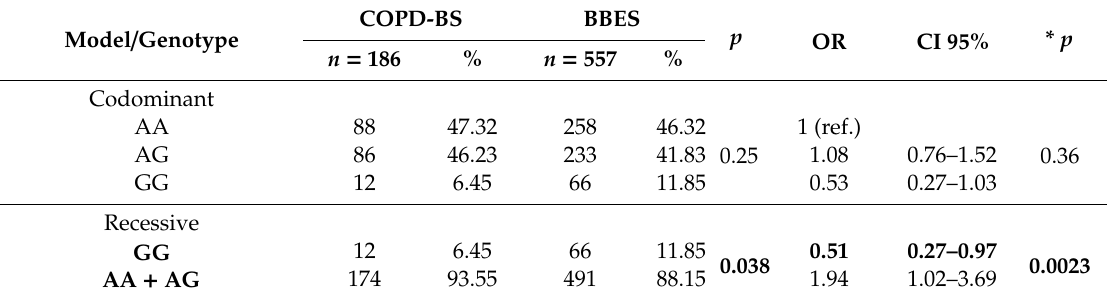
Table 3. Analysis by genetic models of rs13118928 in exposed to biomass-burning smoke with and without